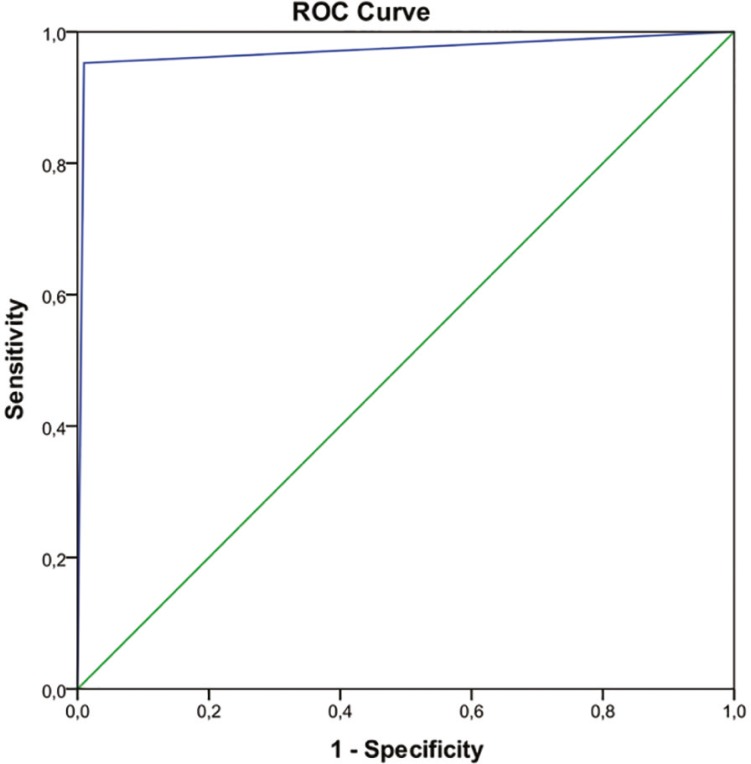
Receiver operating characteristic (ROC) curve for predicting recipients’ clinical pregnancy using donors’ implantation rate as test variable